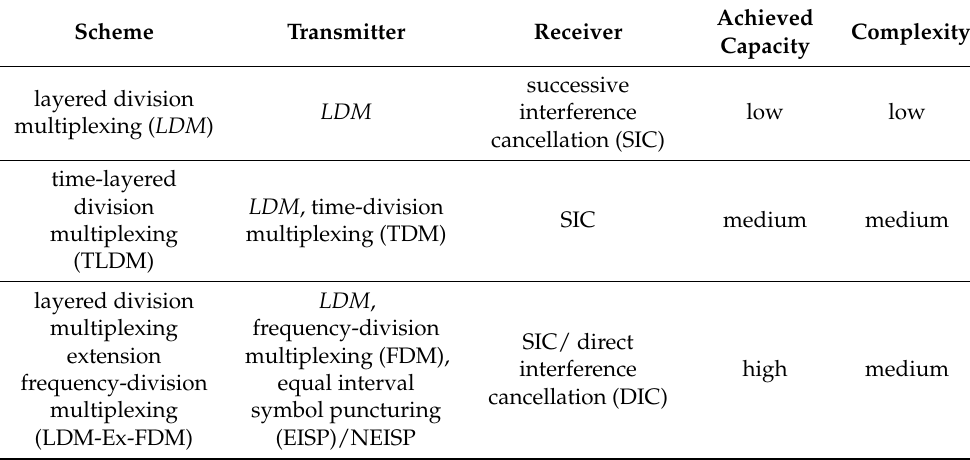
Table 4. The comparison among several LDM